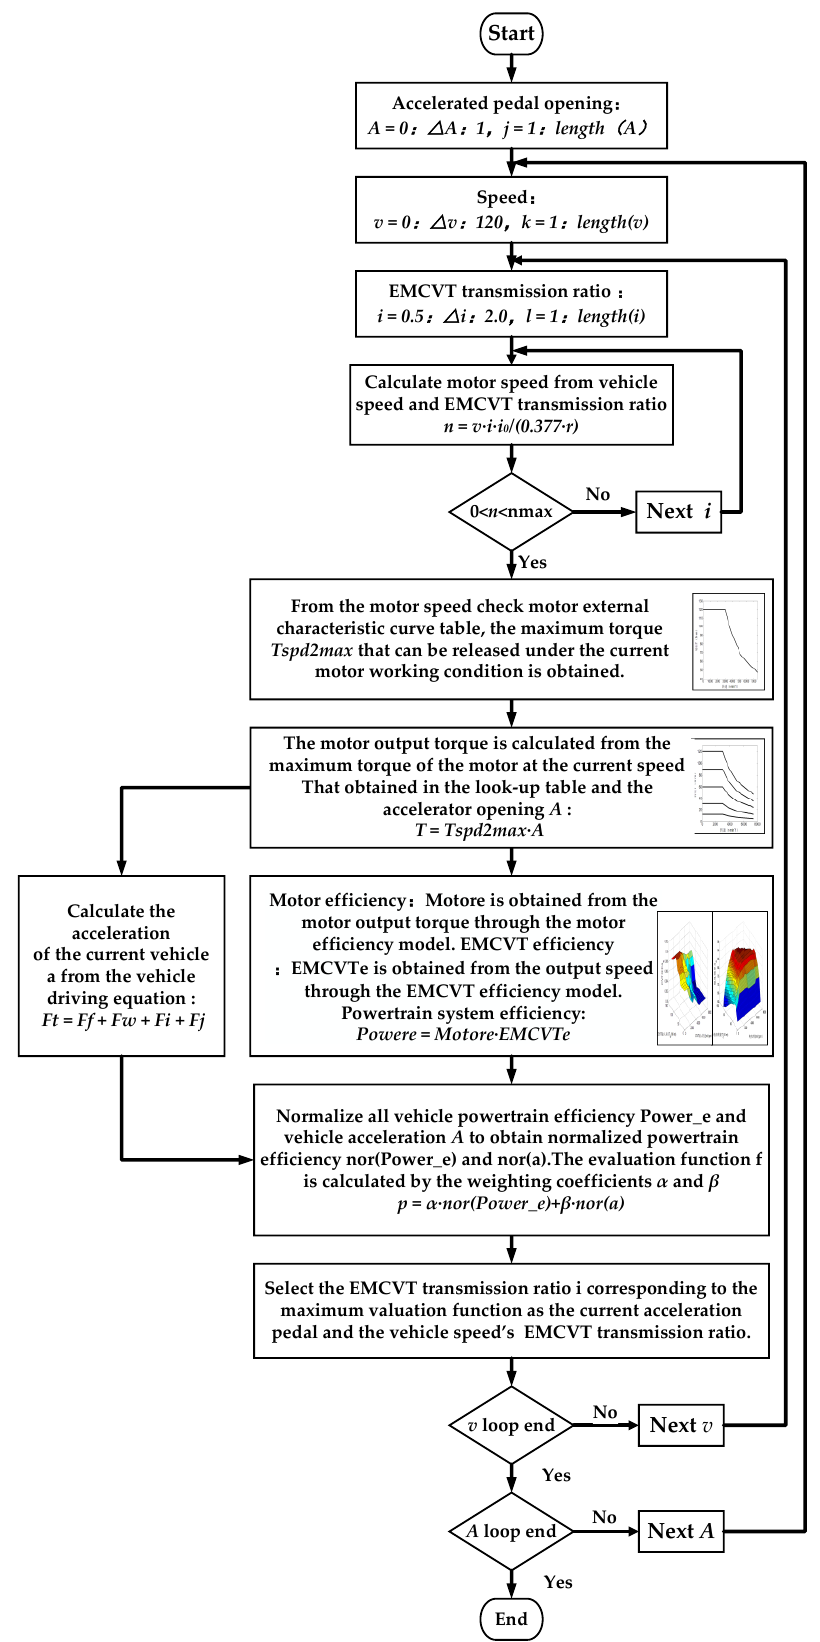
Figure 6. The powertrain working point calculation process. The calculation results for △𝐴 = 0.02, △𝑣 = 2, and △𝑖 = 0.01 are provided in Figure 7.